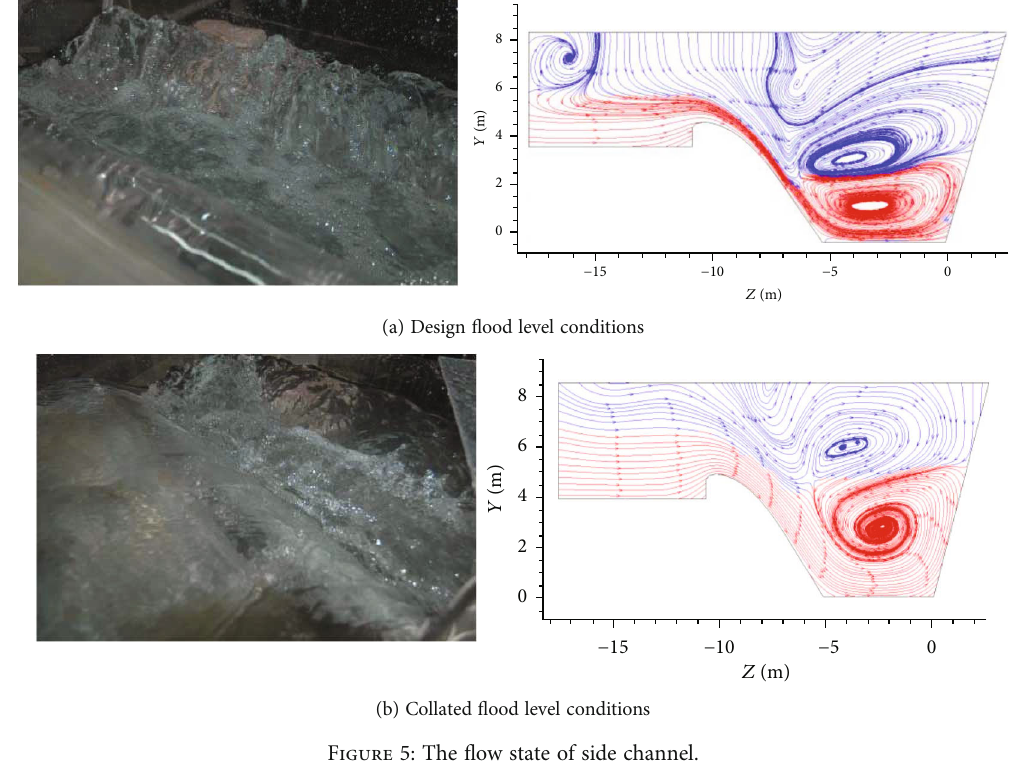
Figure 5: The fl ow state of side channel.